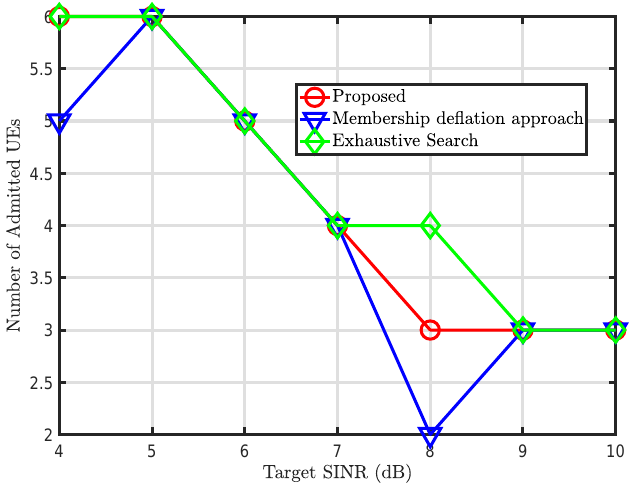
Figure 4. Total admitted user equipments (UEs) versus target